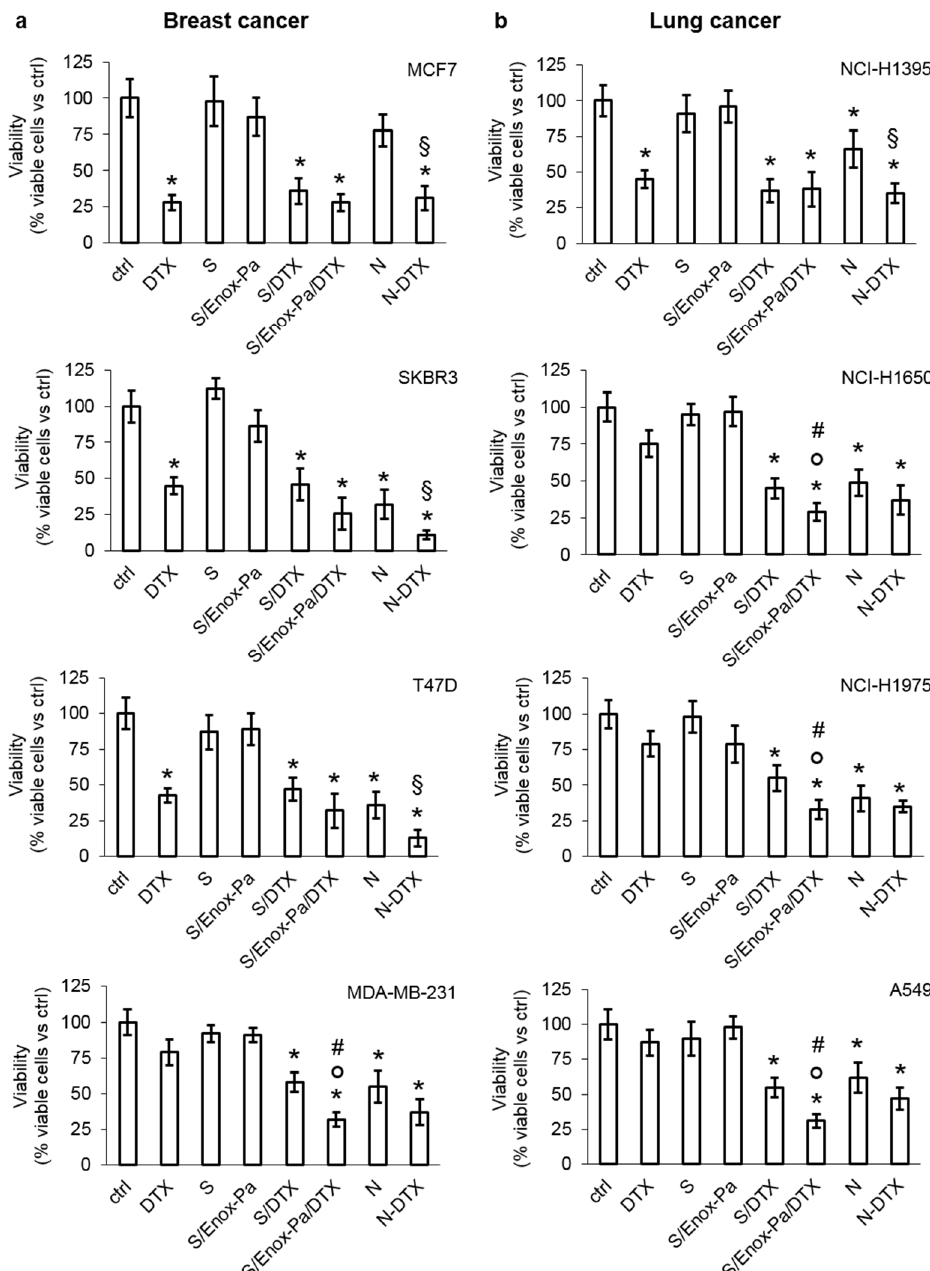
Figure 1. Viability of breast and non-small cell lung cancer cells treated with free docetaxel and different formulations of SEDDs. ( a ) Human breast MCF7, SKBR3, T47D, and MDA-MB-231 cells and ( b ) human non-small cell lung cancer NCI-H1395, NCI-H1650, NCI-H1975, and A549 cells were incubated for 72 h with fresh medium (ctrl), 80 µ M free DTX, 0.25% v / v blank SEDDs (S), Enox-coated SEDDS (S/Enox-Pa), SEDDS containing DTX (80 µ M final concentration; S/DTX), and Enox-coated SEDDS containing DTX (80 µ M final concentration; S/Enox-Pa/DTX). Nintedanib (1 µ M; N), alone or co-incubated with 80 µ M DTX (N + DTX), was included as an inhibitor of FGFR1. Cell viability was measured by a chemiluminescence-based assay in quadruplicates. Data are presented as means ± SD (n = 3). * p < 0.001: vs. ctrl; ◦ p < 0.001: S/Enox-Pa/DTX vs. DTX; # p < 0.01: S/Enox-Pa/DTX vs. S/DTX; § p < 0.01: N + DTX vs.